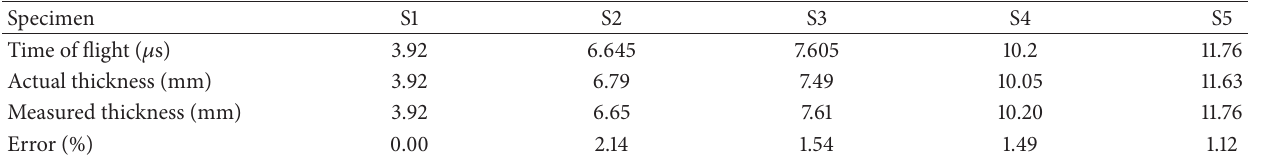
Table 3: The time of flight and the measured thickness of foreign substances.